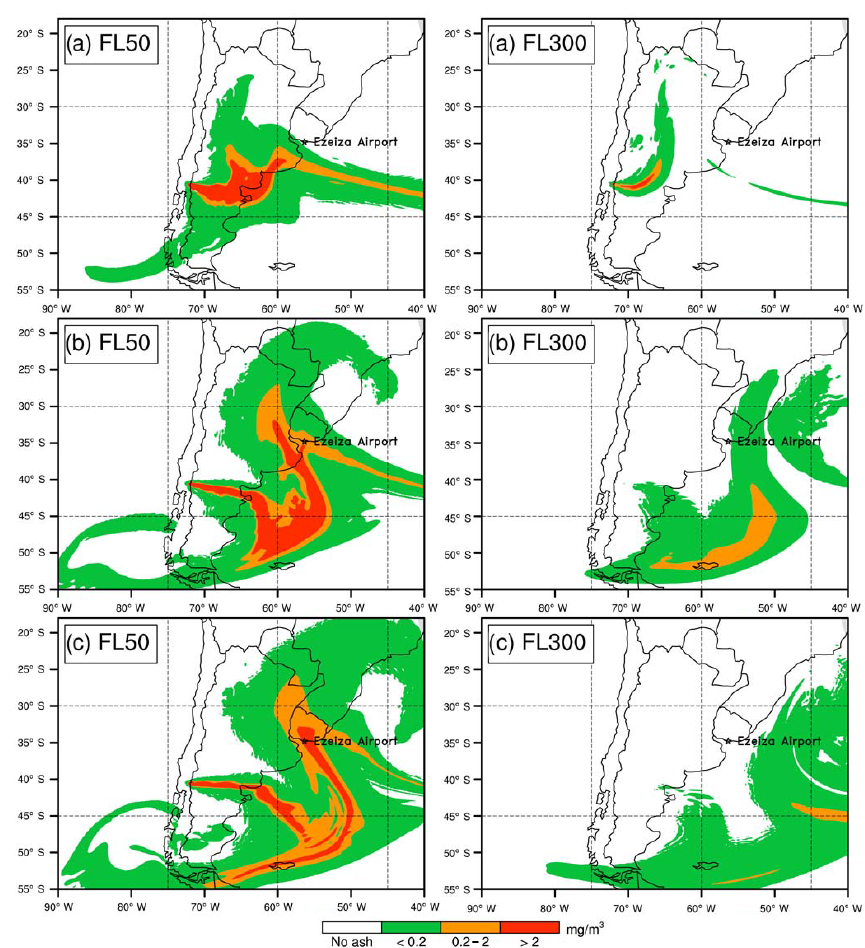
Figure 8. NMMB-MONARCH-ASH flight level ash concentrations (mass loading; mgm − 3 ) for the 2011 Caulle eruption before and after closure of the Buenos Aires (Ezeiza) airport and air space. Results for FL50 (left panels) and FL300 (right panels) for (a) 6 June at 11:00UTC, (b) 7 June at 04:00UTC, and (c) 7 June at 12:00UTC. Safe ash concentration thresholds are shown (red contours illustrate “no flying”